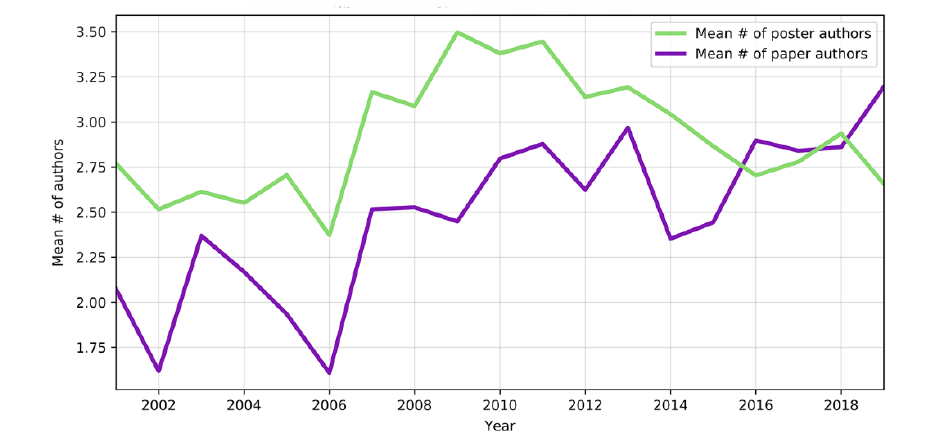
Figure 2 Mean number of authors per presentation type,